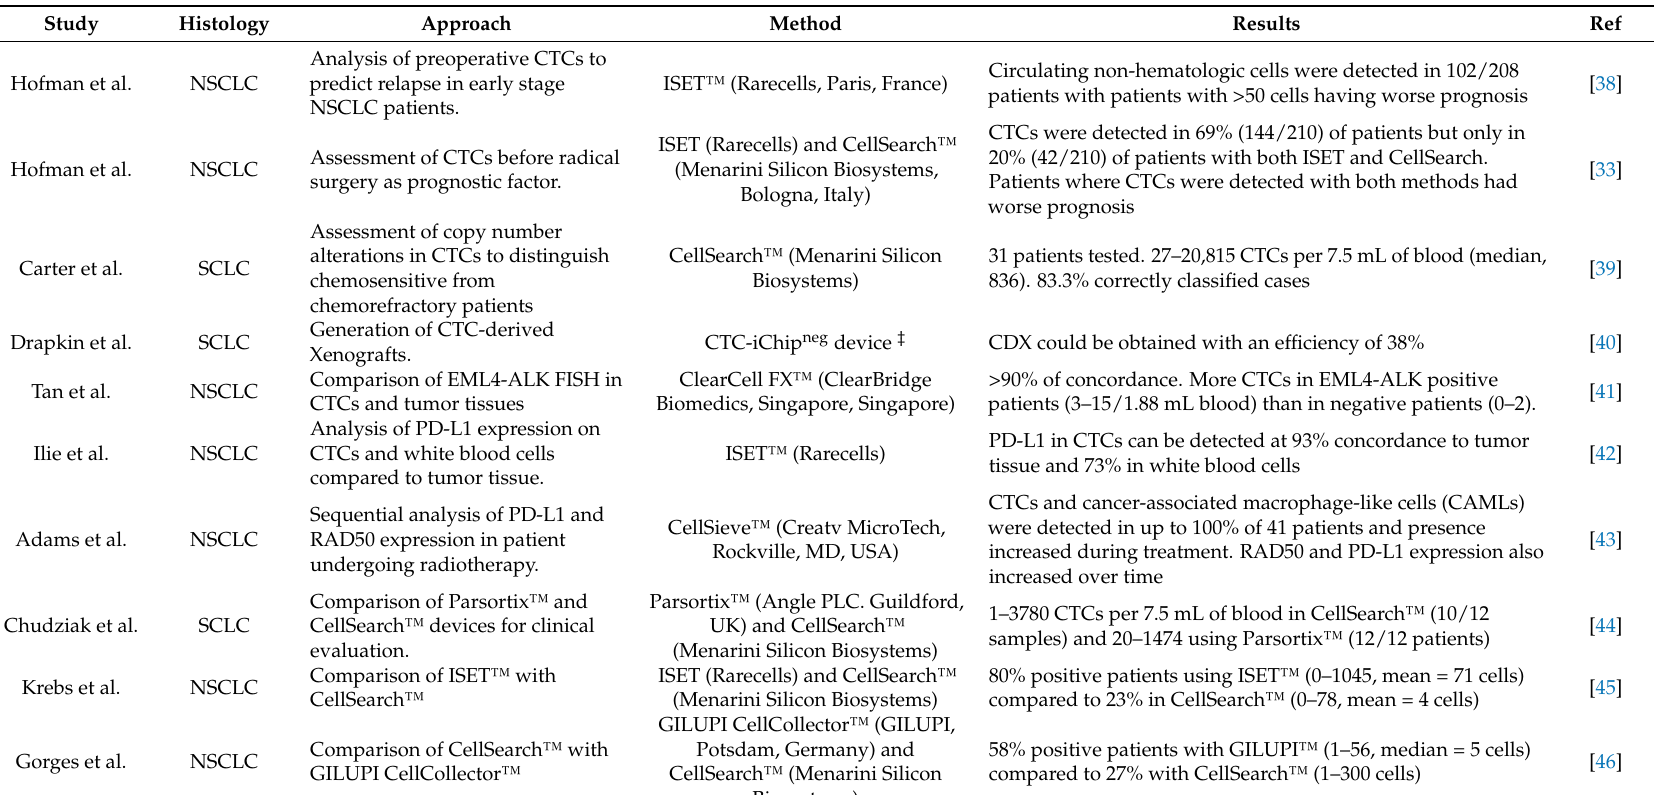
Table 1. Technical advancements in circulating tumor cell (CTC) research for lung